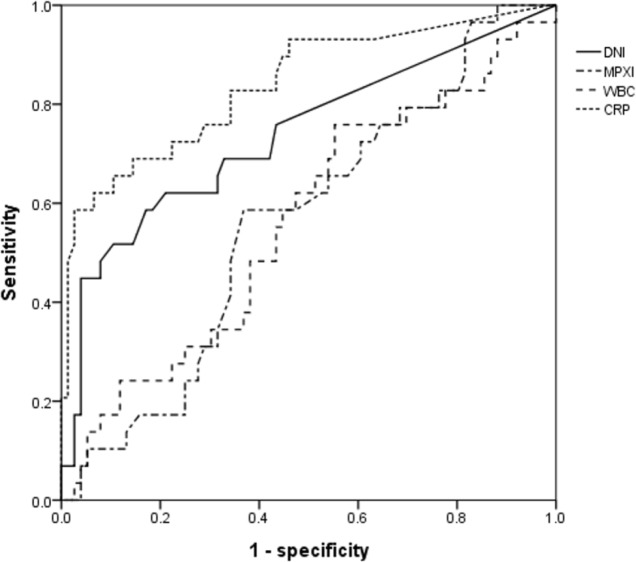
Receiver operating characteristic curves of inflammatory markers.DNI, delta neutrophil index; MPXI, myeloperoxidase index; WBC, white blood cell; CRP, C-reactive protein.